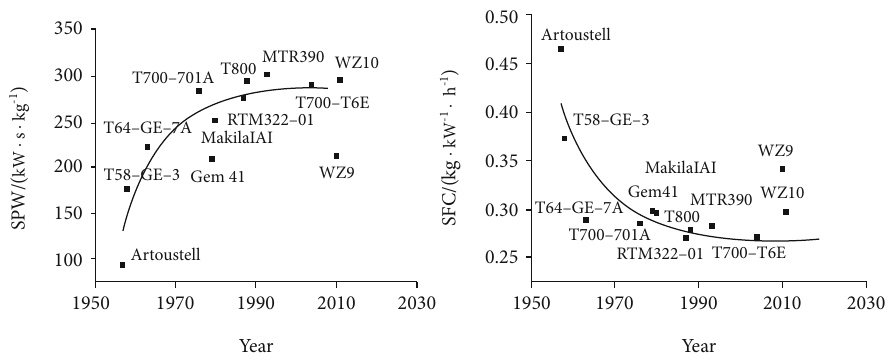
Figure 1: Technical trend of representative conventional turboshaft engines